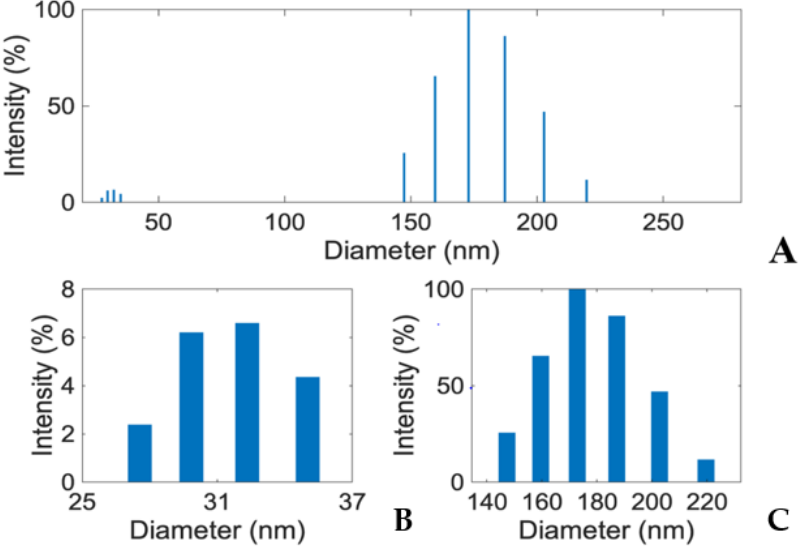
Figure 6. ( A ) Dynamic Light Scattering (DLS) analysis showing two distinct peaks (~32 nm and ~170 nm) in E1800 suspension (1 mg/mL). Mean particle diameter was 169.8 nm with a relative variance of 0.049 and a root mean squared error of 3.2 × 10 − 2 . Panels ( B , C ) respectively show zoomed in views of the particle size (25–37 nm) and aggregate size (140–220 nm) distributions from the DLS analysis in panel ( A ). Note that larger particles/aggregates scatter light more effectively than smaller particles. Thus, the exact quantitative proportions of the various particles and aggregates cannot be determined from DLS